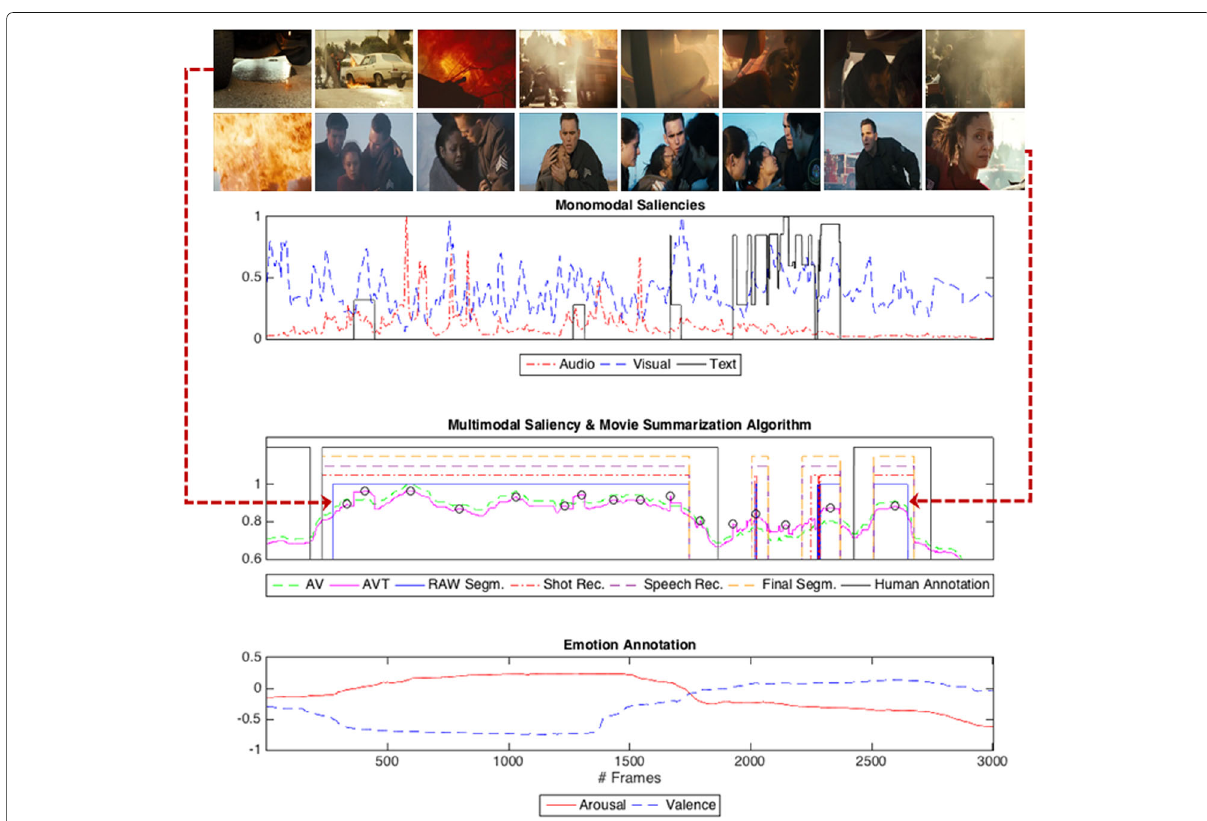
Fig. 10 Illustration of saliency curves, summarization algorithm, and emotion curves. Monomodal saliency curves for the three modalities (audio, visual, and text). Multimodal saliency, av vs. avt, where the weight w = 0.1 and summarization algorithm (illustrating the effect of reconstruction opening by showing the raw (automatically) selected segments, the shot reconstructed and the speech reconstructed segments) and the manual selected segments (by the human annotators). Emotion annotation illustrated by the two dimensions arousal and valence; for 3000 frames, scene from the movie “CRA”. Keyframes ( top ) correspond to the indicated saliency peaks. Best viewed in